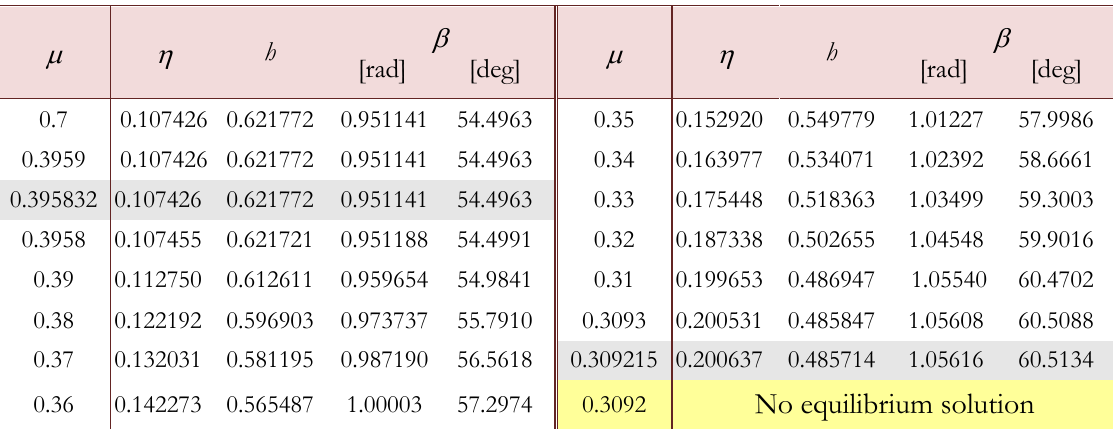
Table 1: “Exact” critical solution values of triplet  , h ,  obtained for the complete semi-circular arch by the analytical analysis at variable friction coefficient  . Sliding joints appear at  =  /2 rad = 90° for 0.309215 =  ms ≤  ≤  rm = 0.395832 and at  =  s = 0.499796 rad = 28.6362° for  =  ms =